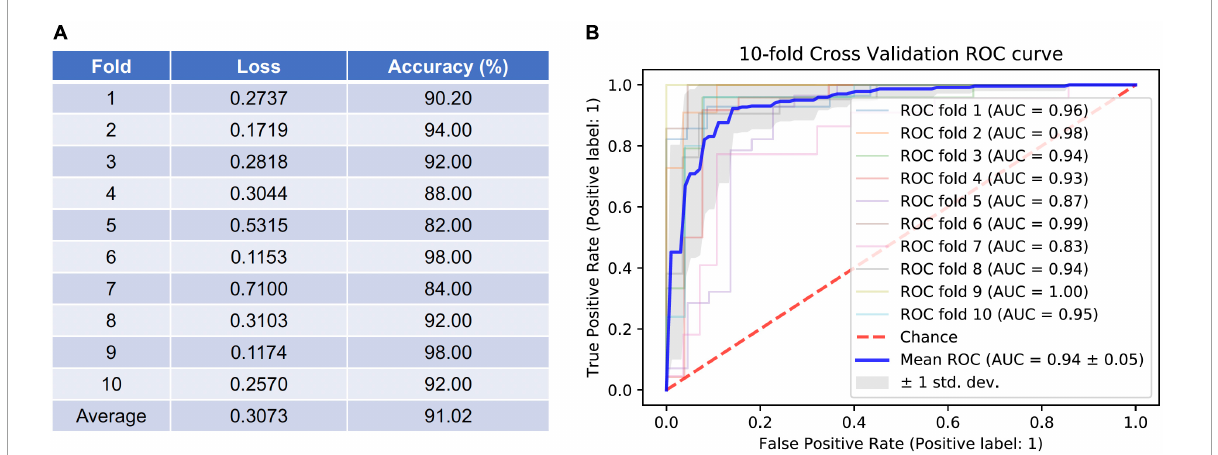
FIGURE3 Accuracy and loss per fold and areas under the curve (AUC) for the receiver operating characteristic curves (ROC) achieved by the AI model for classifying GS and early NTG. (A) Accuracy and loss per each fold were evaluated. The average loss was 0.3073 (0.1153–0.7100), and average accuracy was 91.02% (82.00–98.00%). (B) The area under the curve (AUC) for the receiver operating characteristic curve (ROC) were calculated for the CNN model with 10-fold cross validation. The mean AUC value was 0.94 ± 0.05 (0.83–1.00). GS: glaucoma suspect; NTG: normal-tension